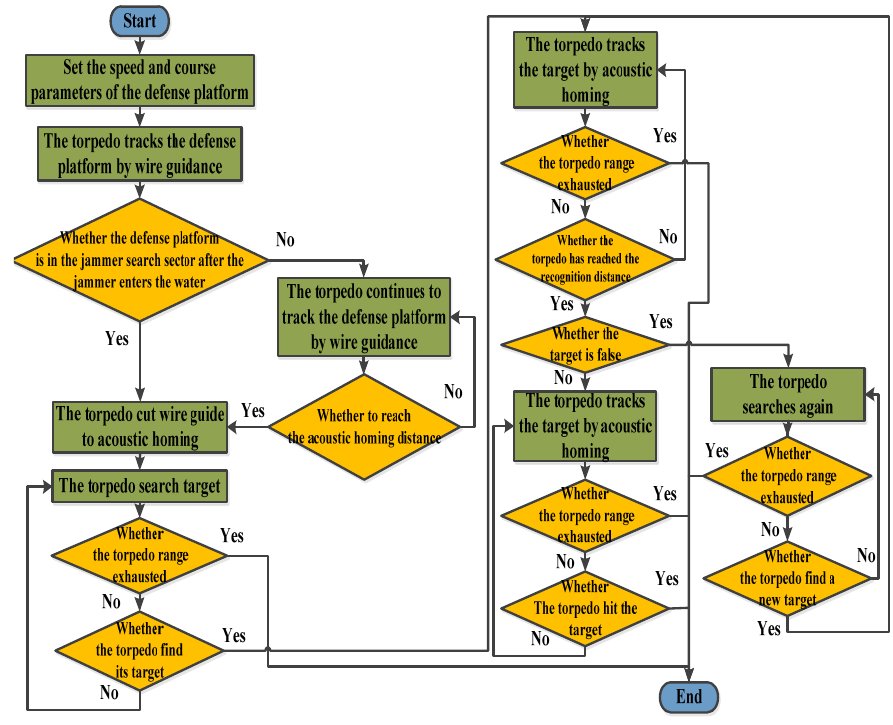
Figure 9. The attack platform module process.